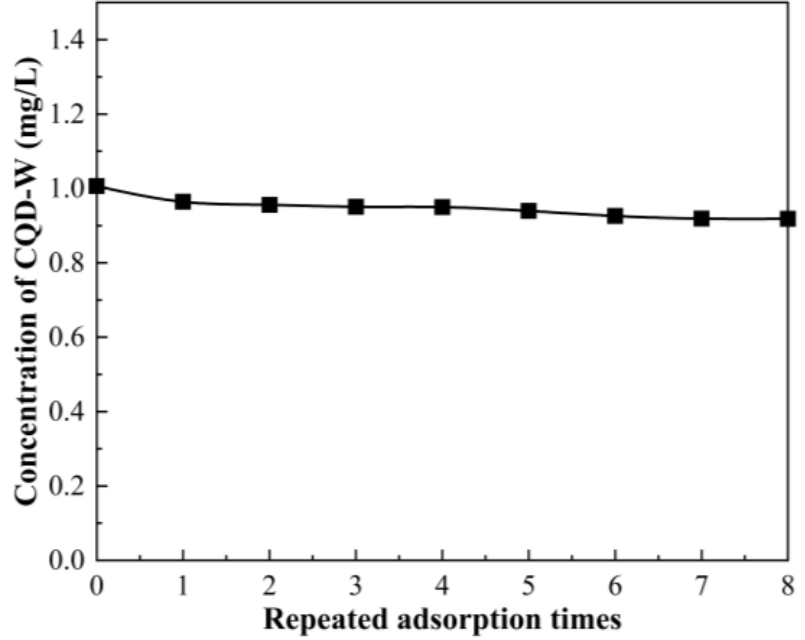
Figure 11. The concentration of CQD-W with the number of repetitions of adsorption.